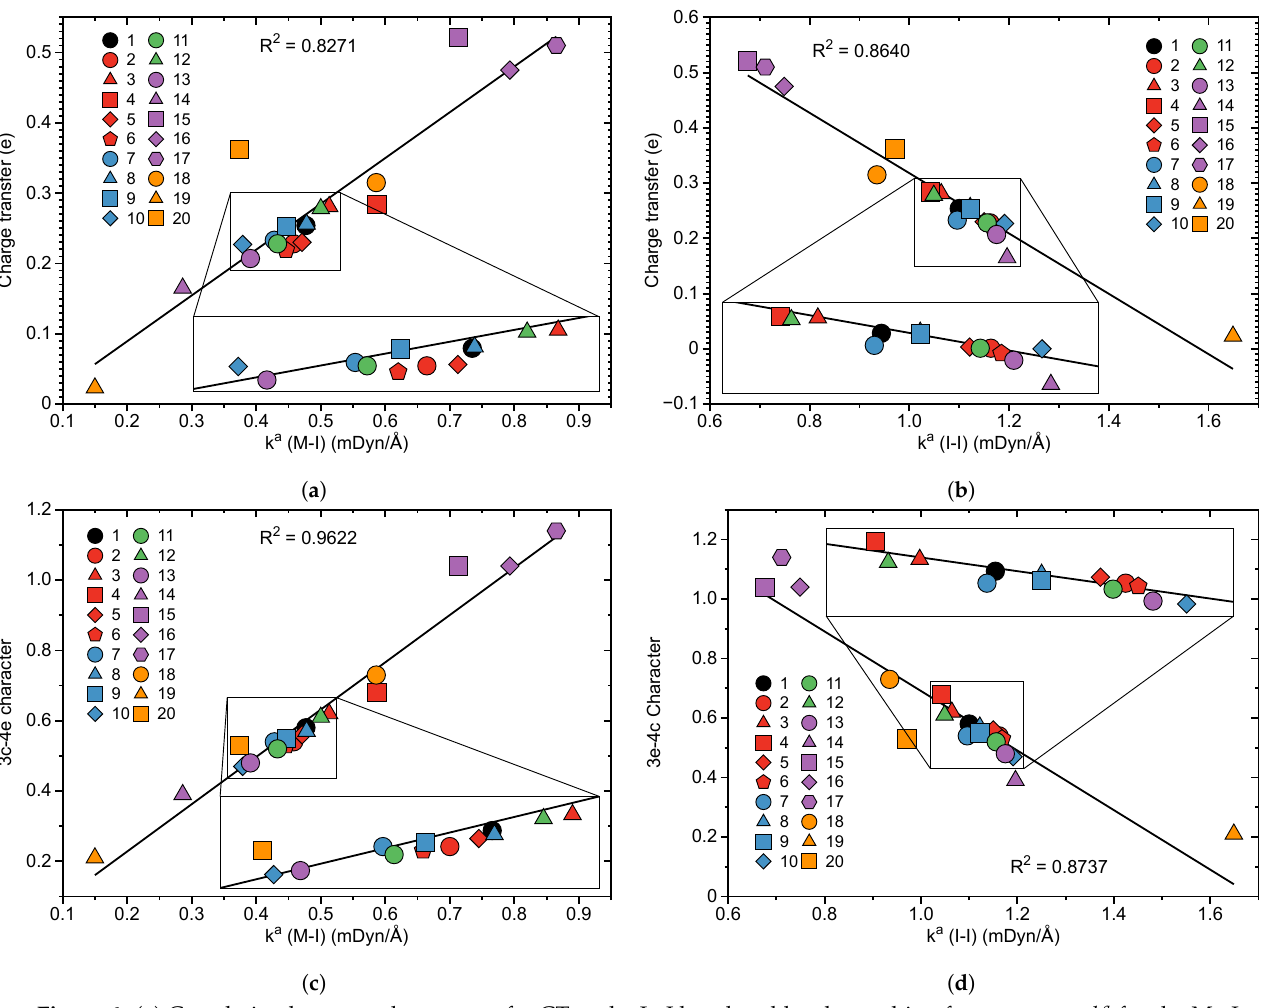
Figure 6. ( a ) Correlation between charge transfer CT to the I − I bond and local stretching force constant k a for the M − I bond; ( b ) Correlation between charge transfer CT to the I − I bond and local stretching force constant k a for the I − I bond; ( c ) Correlation between the 3c–4e bond character of the M − I − I bonds given by BSO n (M − I)/BSO n (I − I) and the local stretching force constant k a of the M − I bond; ( d ) Correlation between the 3c–4e bond character of the M − I − I bonds given by BSO n (M − I)/BSO n (I − I) and the local stretching force constant k a of the I − I bond for 1 – 20 . PBE0–D3(BJ)/aug–cc– pVTZ/PP(M,I) level of